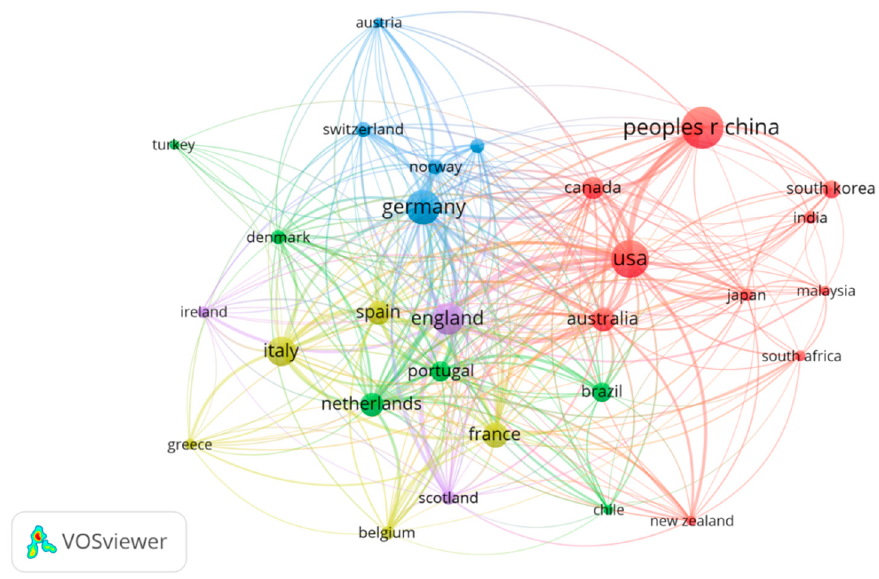
Figure 2. Co-authorship network diagram showing cooperation between countries (with a threshold of 30).